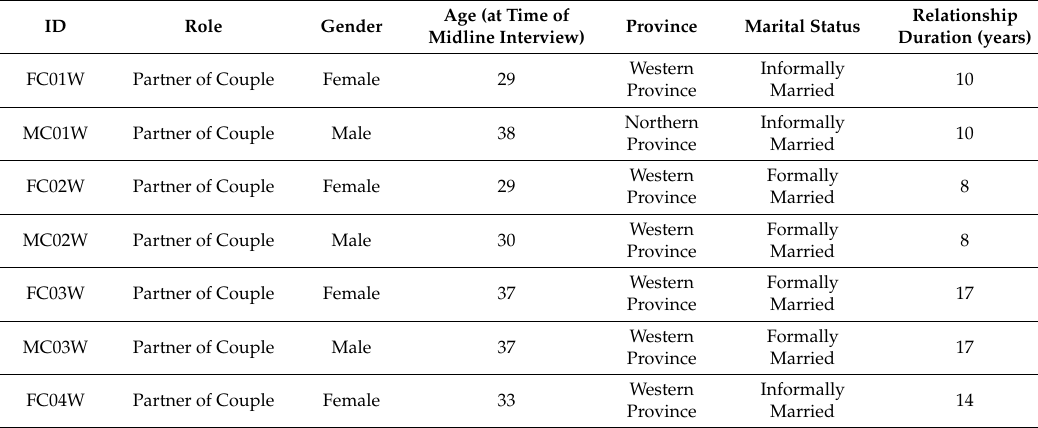
Table 1. Demographics of couples